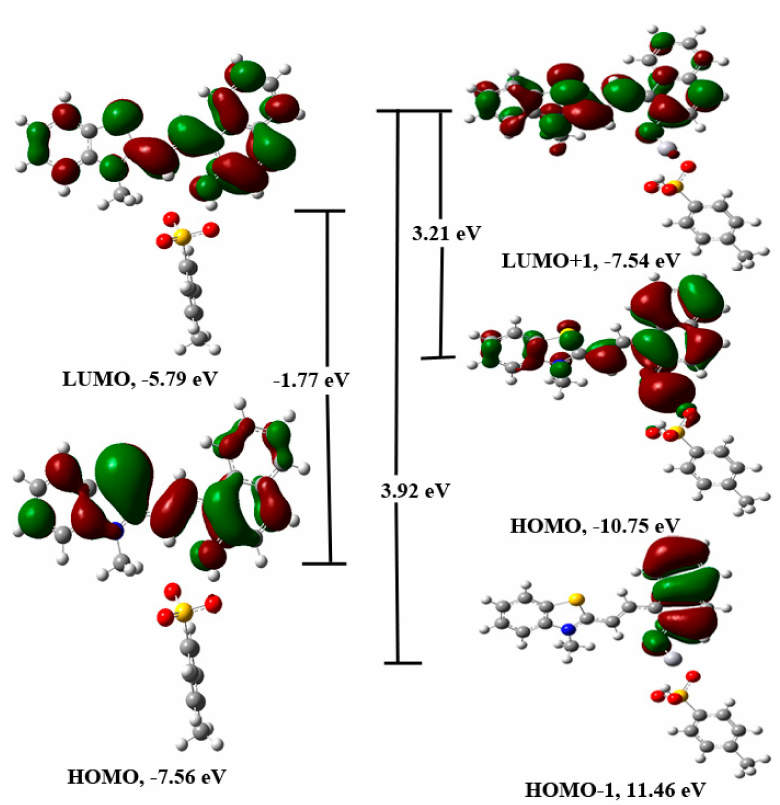
Figure 19. The TD-DFT / PBE1PBE / 6-31 + G(d) / LANL2DZ calculated energy diagram of 1 and 1 -Hg 2 +